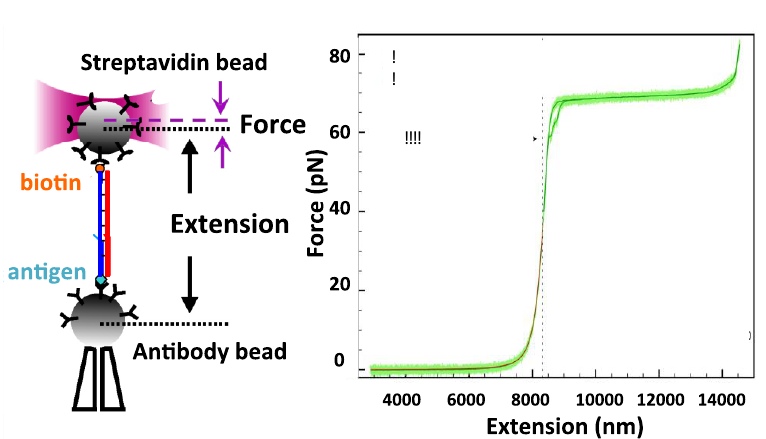
Figure 1. ( Left ) Experimental setup in a DNA pulling experiment. ( Right ) Force-extension curve measured by pulling a single 24kb DNA at standard conditions (T = 298K and 1 M NaCl Tris buffer). At least three force regimes can be identified. At forces below 10 pN the DNA random coil is extended against thermal fluctuations (entropic regime). At forces between 10pN and 60 pN the DNA is stretched above its contour length (8.3 µm) (enthalpic regime). Above 65pN DNA is overextended by ≈ 70% of its contour length (overstretching regime).